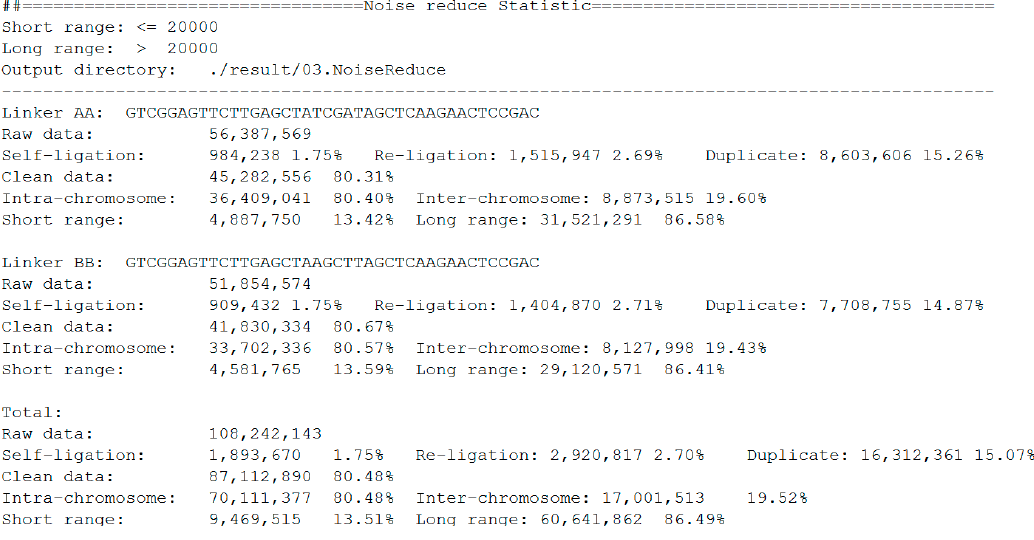
Figure 7. Statistics report of noise redundancy.